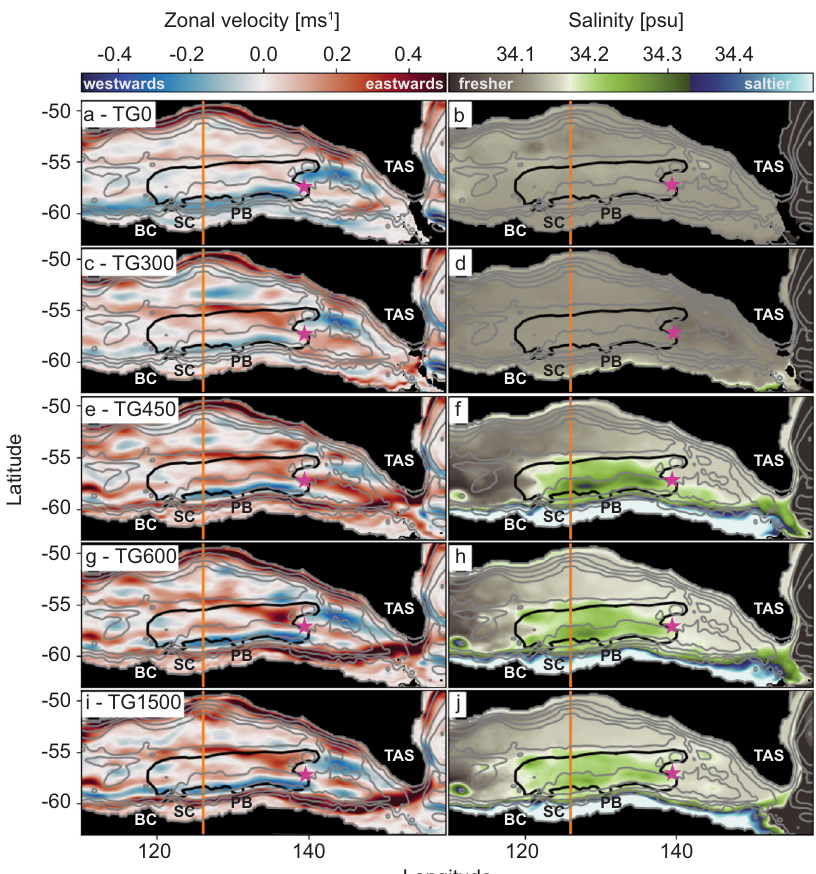
Fig. 3 | Zonal velocities and salinity in the Oligocene AAB. Mean surface values for a , c , e , g , i zonalvelocitiesand b , d , f , h , j salinitywithintheAustralian – Antarctic Basin for different ocean simulations with the Tasmanian Gateway (TG) at a , b 0m representing pre-38 Ma, c , d 300m representing 38Ma, e , f 450m representing 34Ma, g , h 600m representing ~31Ma and i , j 1500m representing post 27Ma.